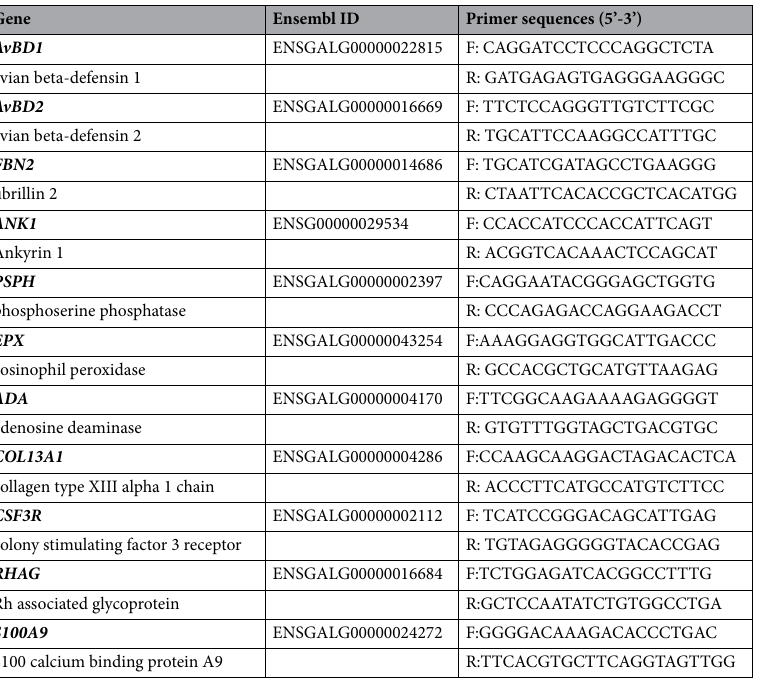
Table 4. Primers used for the qPCR analysis of the target candidate genes for FHS in the femur articular cartilage of